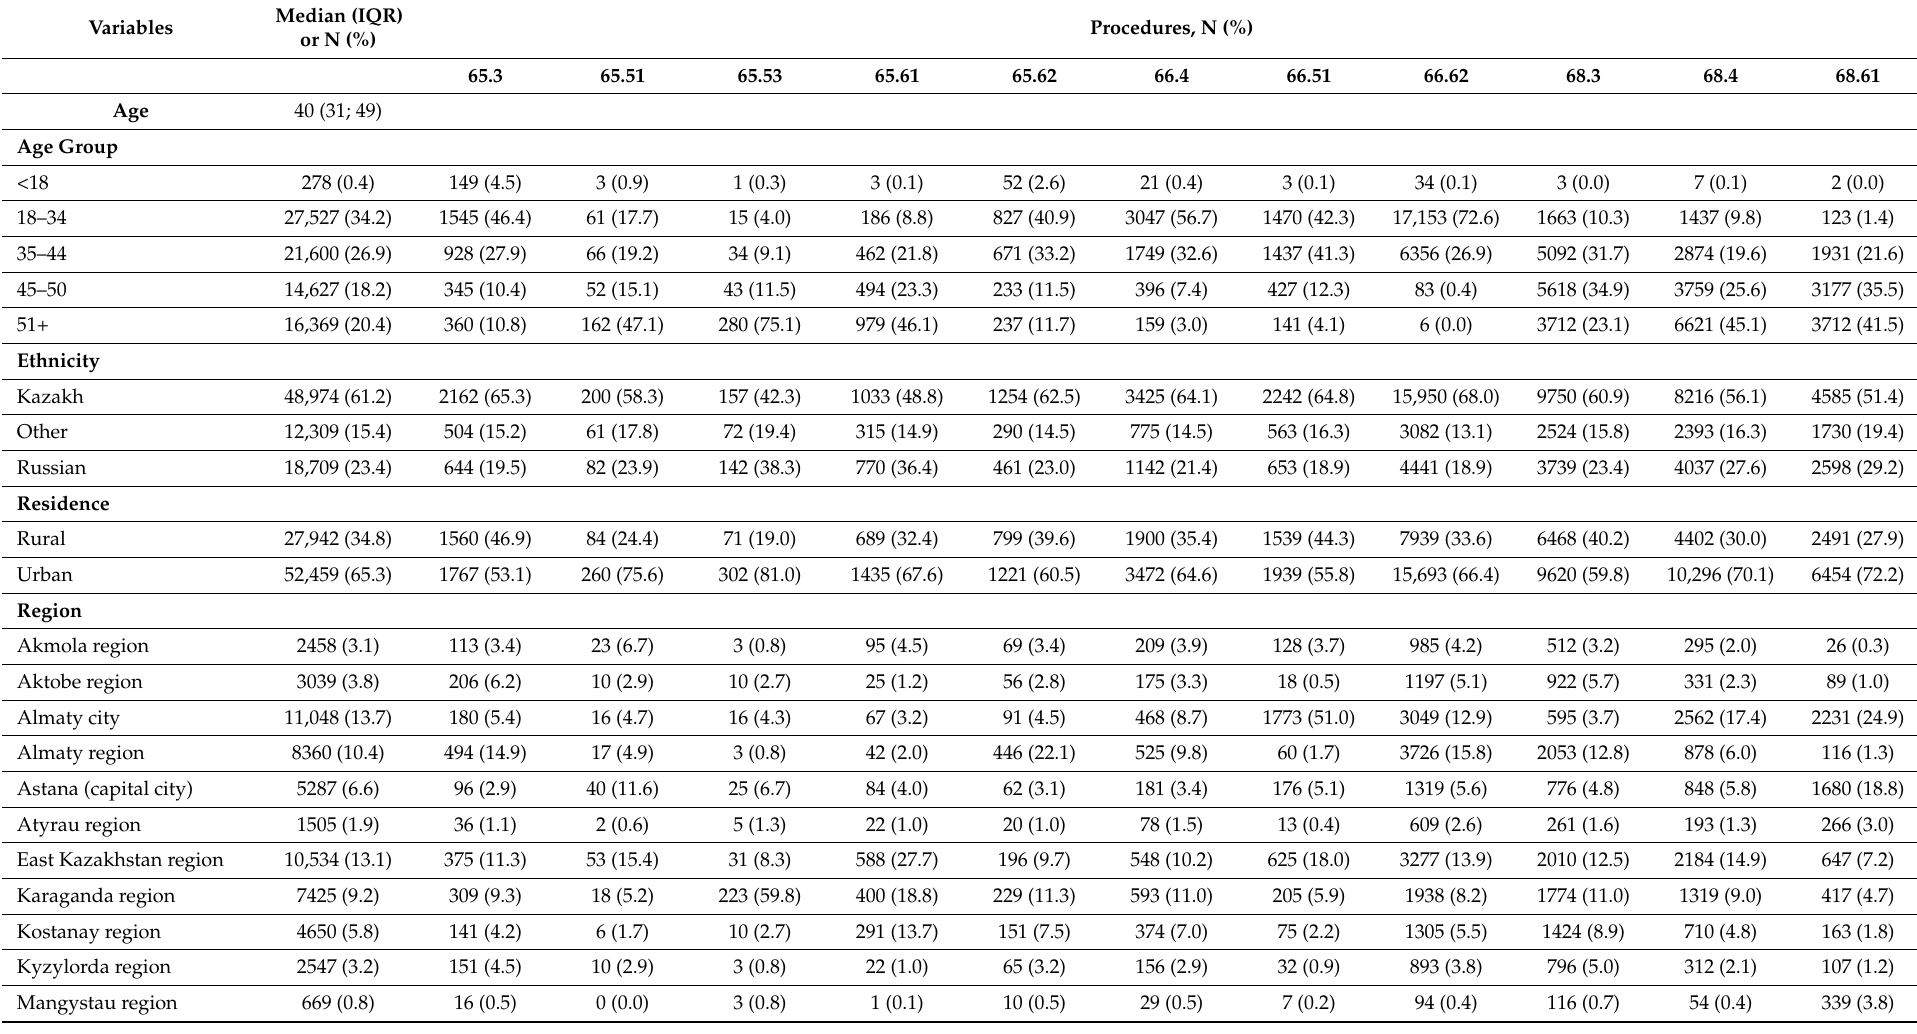
Table 2. Socio-demographic characteristics of the study